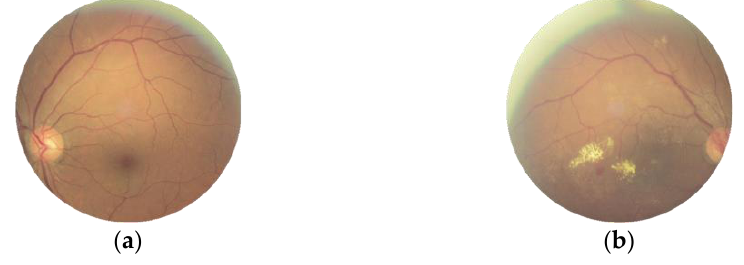
Figure 1. Images of the ODIR dataset. ( a ) No disease. ( b ) Diabetic retinopathy and myopia.